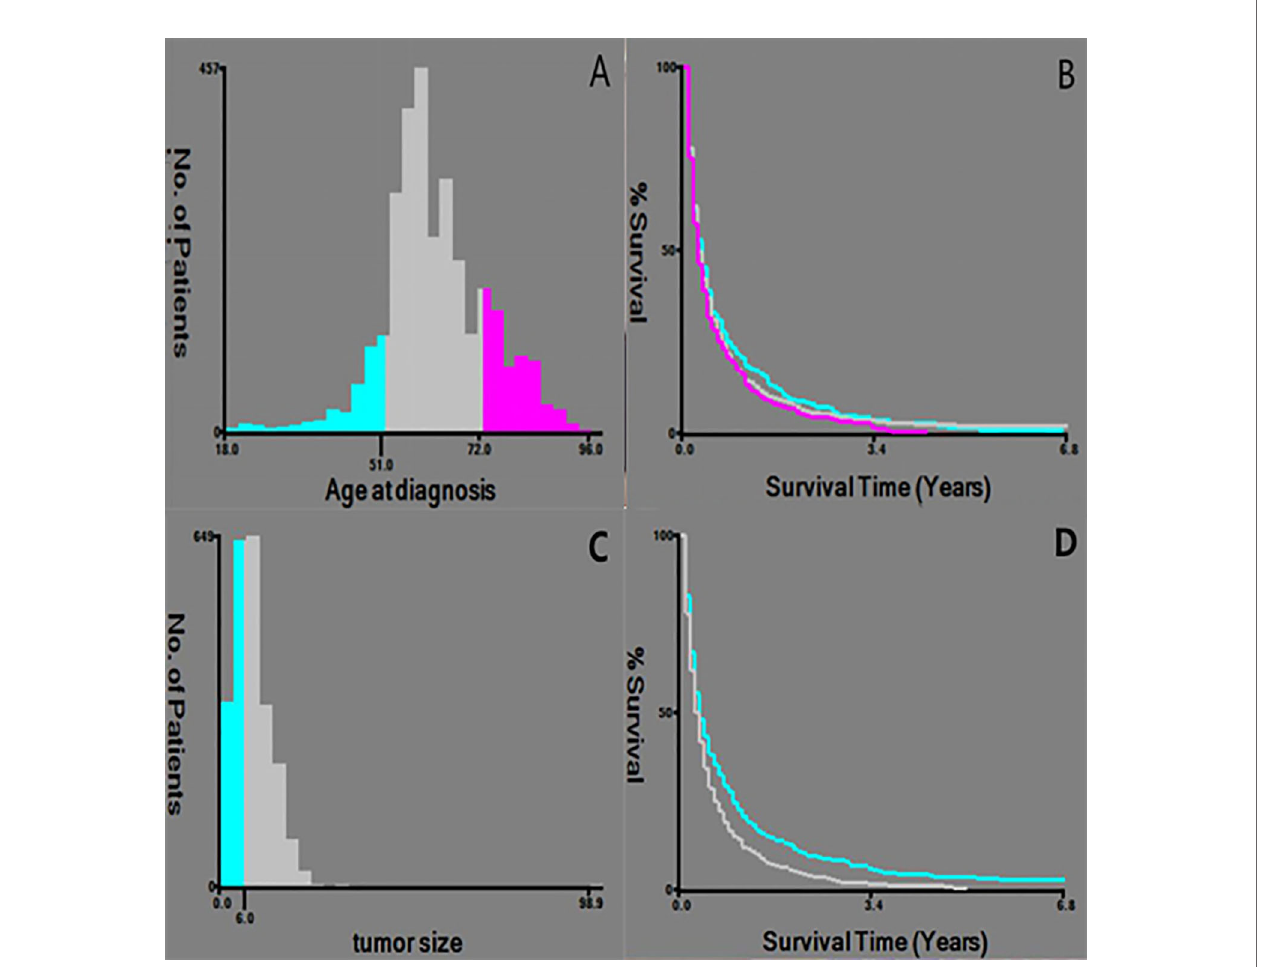
FIGURE 1 | Selection of the best cut-off point for Age and tumor size. (A, C) Histogram showing the best cut-off point; (B, D) Keplan-Meier curve corresponding to the cut-off